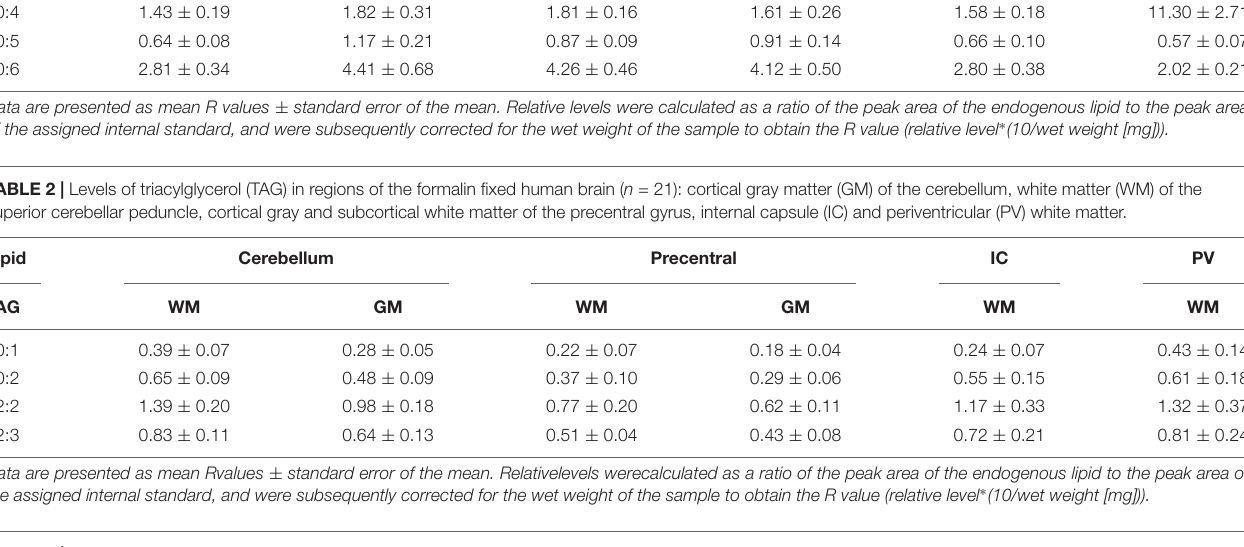
TABLE 3 | Levels of hexosyl ceramide (HexCer) in regions of the formalin fixed human brain ( n = 21): cortical gray matter (GM) of the cerebellum, white matter (WM) of the superior cerebellar peduncle, cortical gray and subcortical white matter of the precentral gyrus, internal capsule (IC) and periventricular (PV) white matter. Lipid Cerebellum